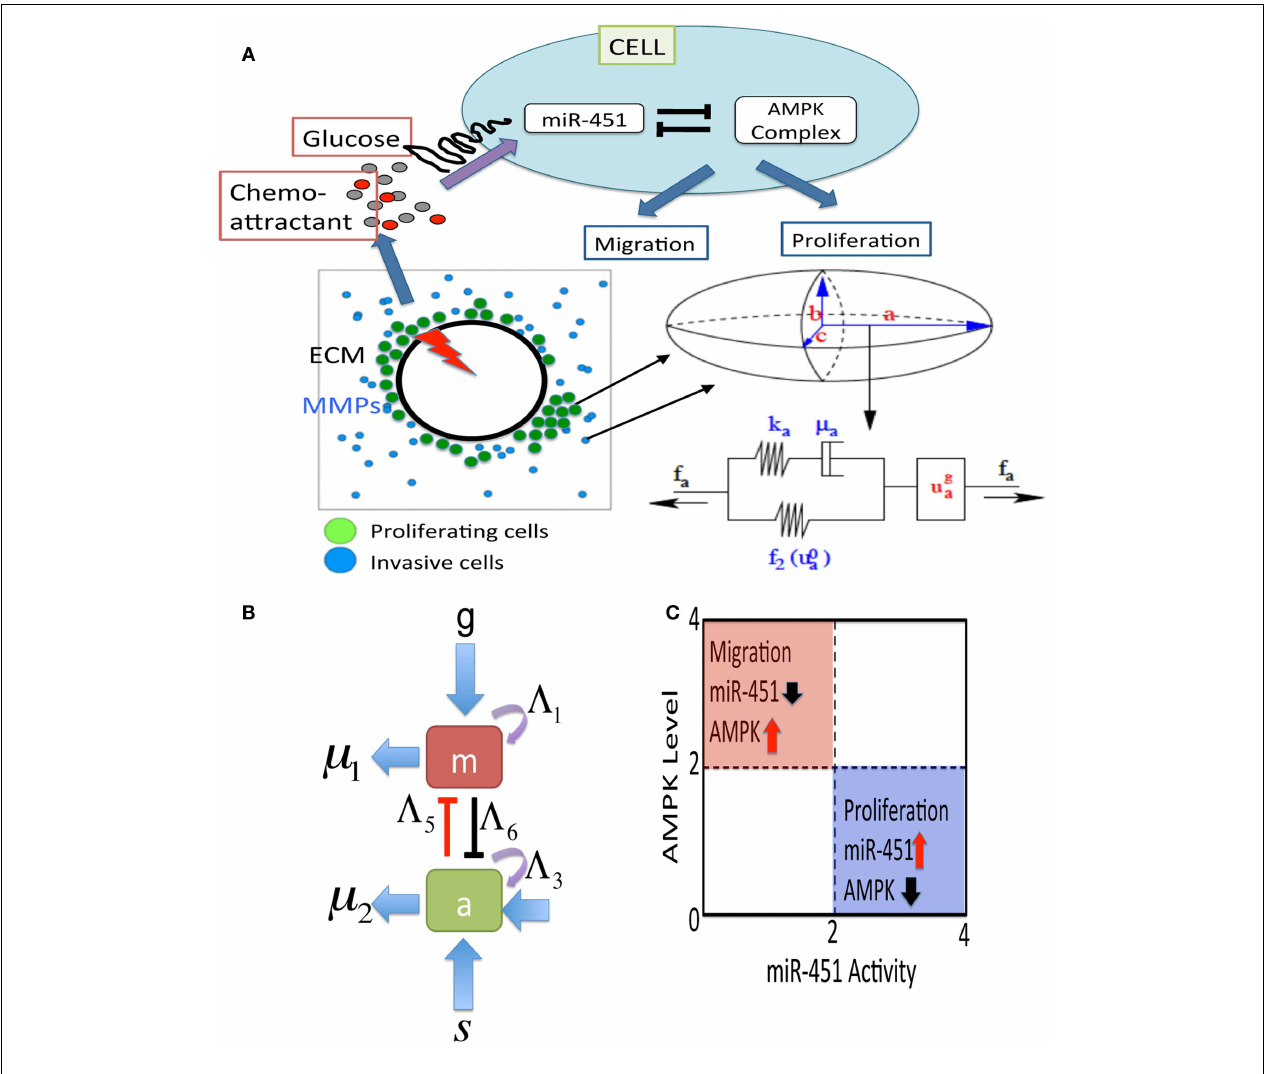
(Bottom, right) changes in the length of the a -axis of a cell (the ellipsoid) under a given force ( f a ; arrow) consist of the passive change in the first component (a Maxwell element in parallel with a non-linear spring) and the change due to the growth ( u g ).The growth component depends on a the levels of miR-451 and AMPK complex, and the force ( f a ).The mechanical and growth elements are the same along all axes. (B) miR-451 activity and levels of its target complex (CAB39/LKB1/AMPK) were represented by “ m ” and “ a ,” respectively. (C) The migratory and proliferative regions based on miR-451 activity and AMPK